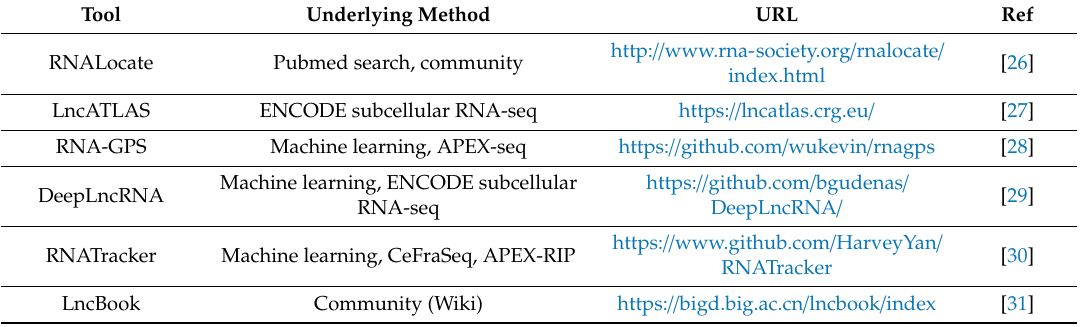
Table 1. Webtools and software to study long noncoding RNA (lncRNA) subcellular localization.